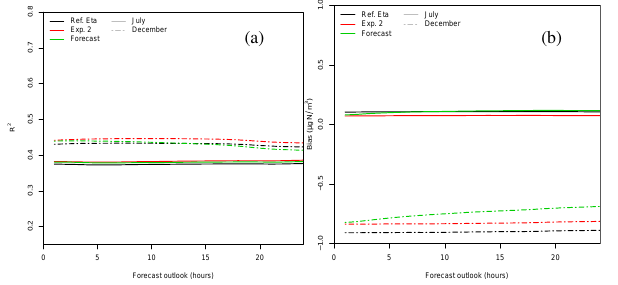
Fig. 11. Verification statistics for forecasts of NO 2 (compared to Exp. 2, which was used to provide the initial conditions, and to Ref . Eta) in terms of correlation (a) and bias (b) . The line colour indicates the simulation, the line type denotes the month in ques- tion.